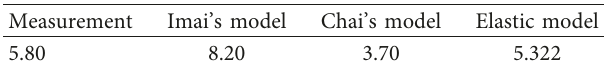
Table 5: Settlement of the plane seepage model (mm).